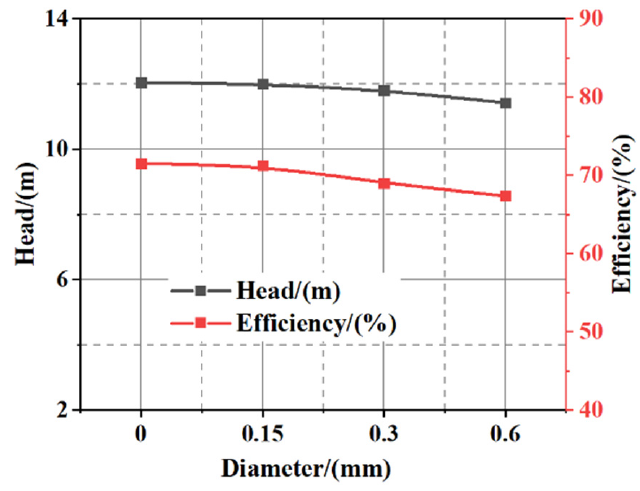
Figure 12. Characteristic curve under different particle sizes.